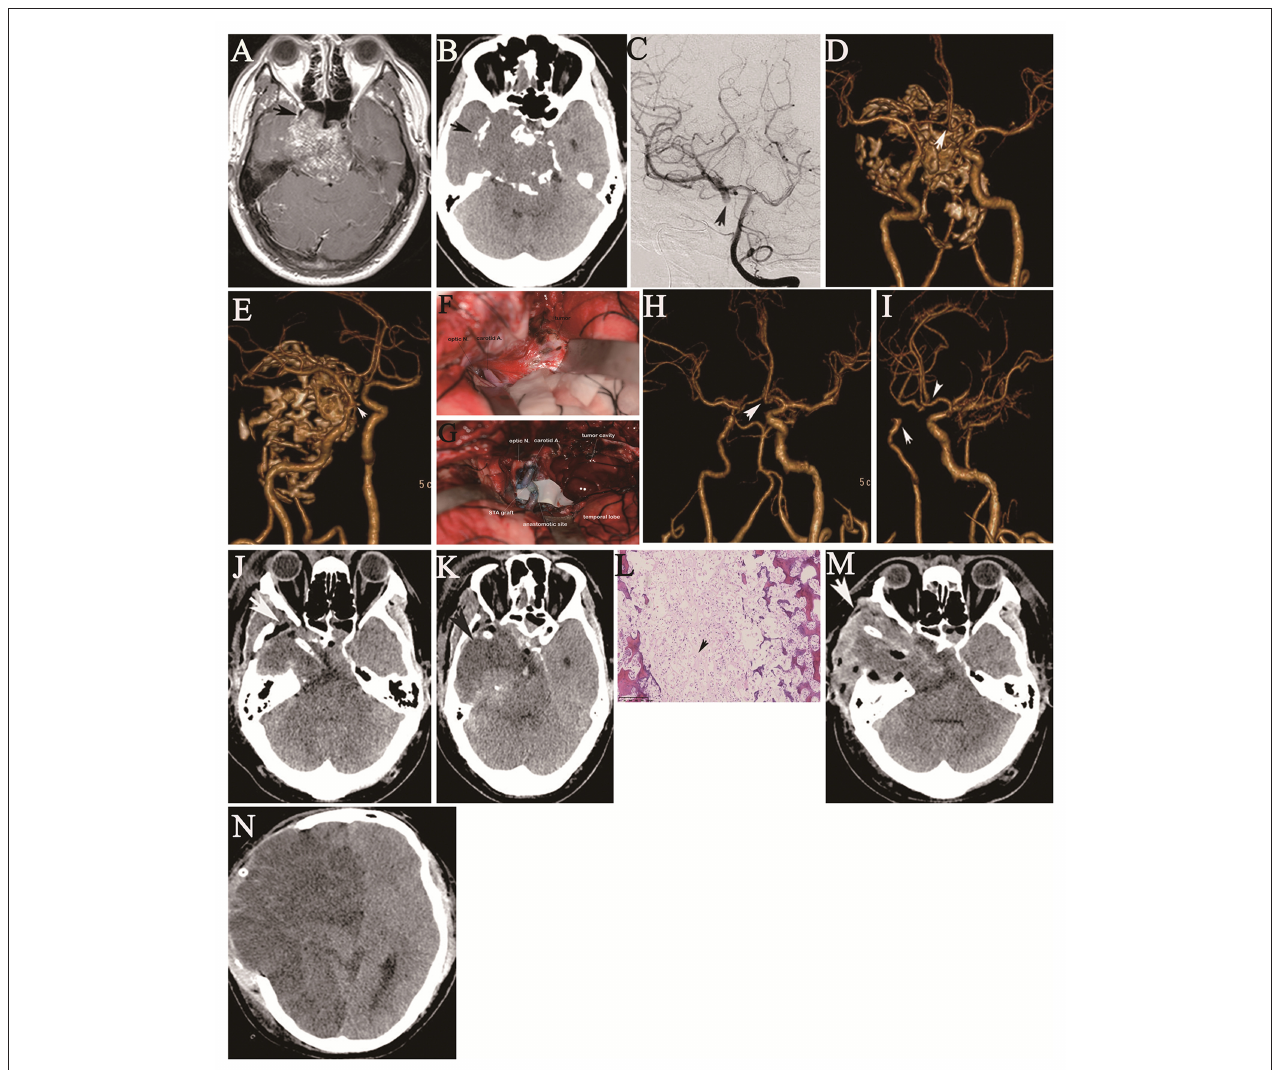
FIGURE 3 | A 36-year-old man had deteriorating double vision for two years and a 1-week history of right facial numbness, resulting in the inability to work as a truck driver. Axial preoperative contrast-enhanced MRI shows a large tumor in the sphenopetroclival area encasing the cavernous ICA (A) , and axial CT reveals the tumor around fragments of destroyed bone (B) , as indicated by the arrows. Angiography of the left vertebral artery shows full cross-filling of the right PComA to the right ICA after balloon occlusion of the right ICA, as indicated by the arrow (C) . Anterior (D) and oblique (E) CTA shows the tumor invading the supraclinoid ICA (arrow). Intraoperative images show the exposed tumor in the anterior area of the middle cranial fossa and parasellar region through a frontotemporal craniotomy (F) and the interposed STA graft between the proximal and distal cut ends of the ICA caused by a supraclinoid ICA tear during resection of the tumor in the sphenopetroclival area (G) . Postoperative anteroposterior (H) and oblique (I) CTA shows the cutoff filling of the right ICA to the right MCA (arrow), with cross-filling of the left ACA to the right ACA (arrow). On the first day after surgery, two axial CT sections (J,K) show gross resection of the tumor in the sphenopetroclival area with normal brain features (arrows). Photomicroscopic image of a cranial chordoma shows characteristic physaliphorous cells (arrow) in the abundant cartilaginous matrix. Hematoxylin and eosin staining; original magnification x100 (L) . Four days after surgery, two axial CT sections (M,N) show a malignant MCA territory infarction with large bone flap